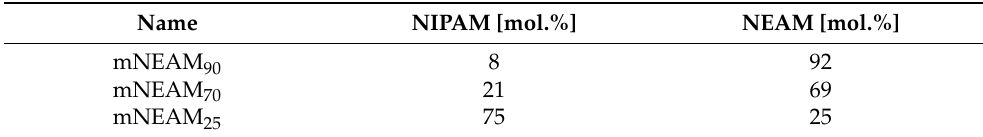
Table 4. Ratio between homopolymers for different blends.